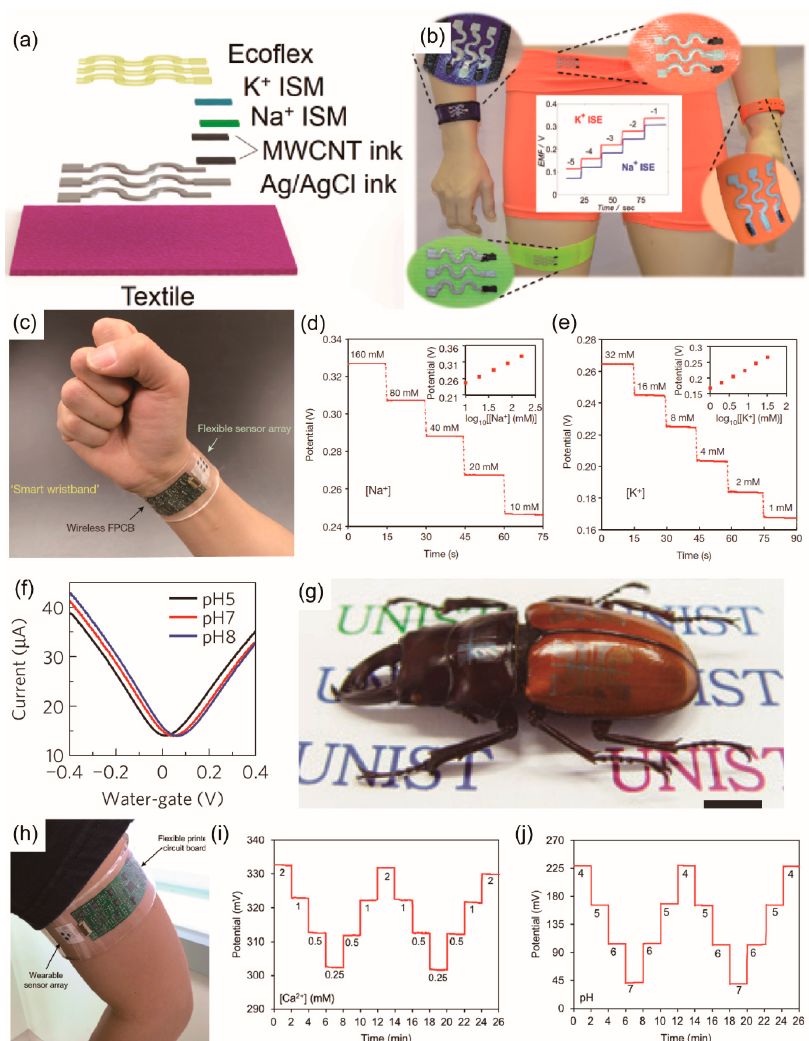
Figure 5. Wearable electrochemical ion sensors and its integrated systems. ( a ) Schematic representation of the tailor-made stretchable materials and manufacturing process. ( b ) Photograph of the printed sensors on different common textiles and typical time trace plots for potassium and sodium. Reprinted with permission from Ref. [122]. Copyright 2016, John Wiley and Sons. ( c ) Photograph of a wearable flexible integrated sensing array and the open circuit potential responses of Na + ( d ) and K + ( e ) sensor, respectively. Reprinted with permission from Ref. [38]. Copyright 2016, Nature Publishing